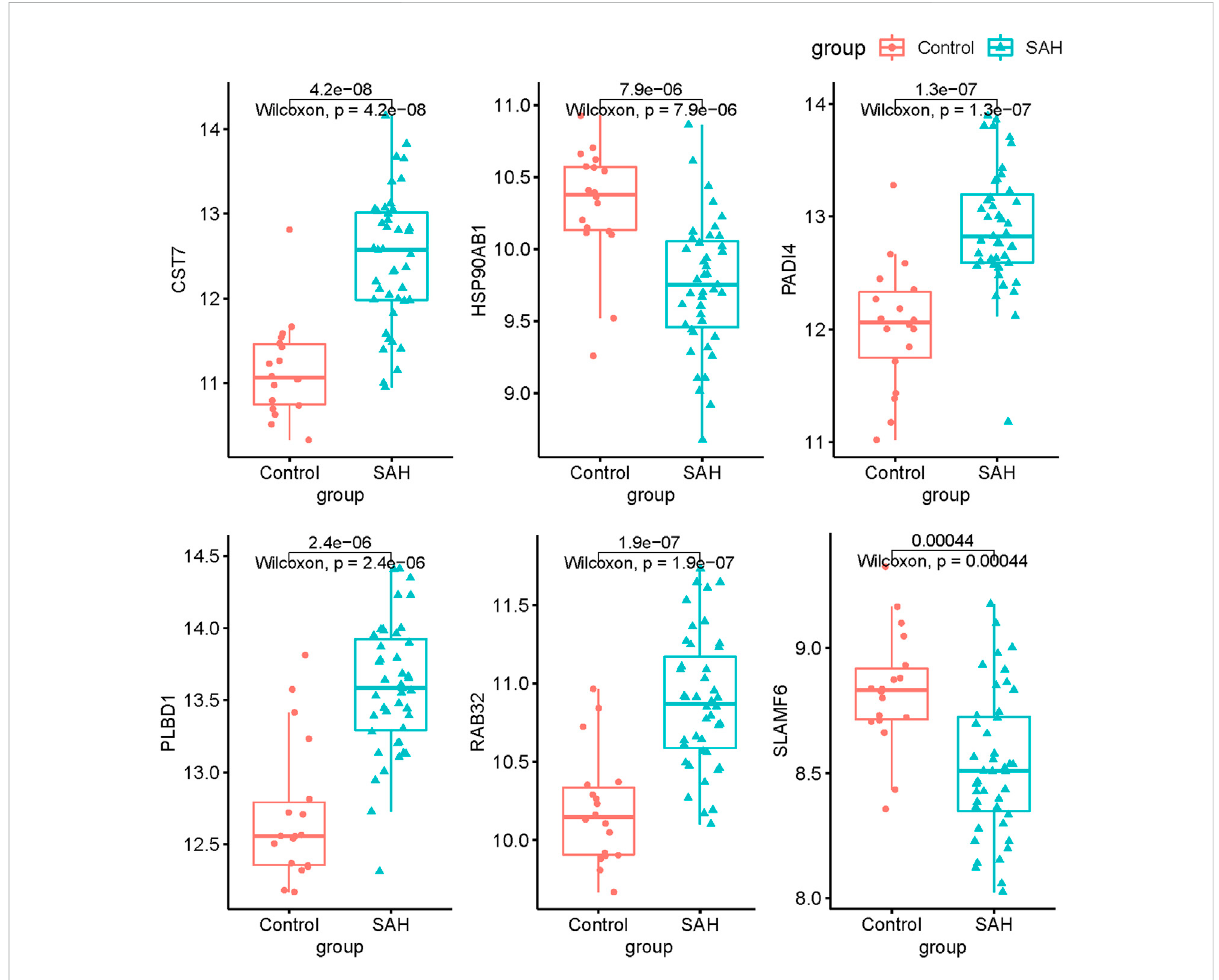
FIGURE 7 The expression levels of signature genes in